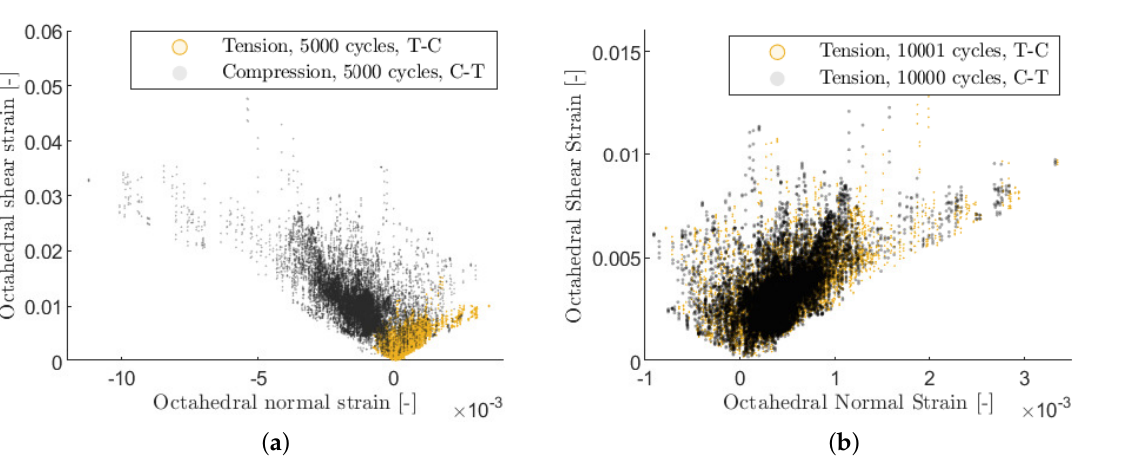
Figure 9. ( a ) Comparison of the strain distribution in matrix after one tensile or compressive block in T-C and C-T sequence ( b ) comparison of the strain distribution in matrix after two tension and compression blocks in T-C and C-T sequence.